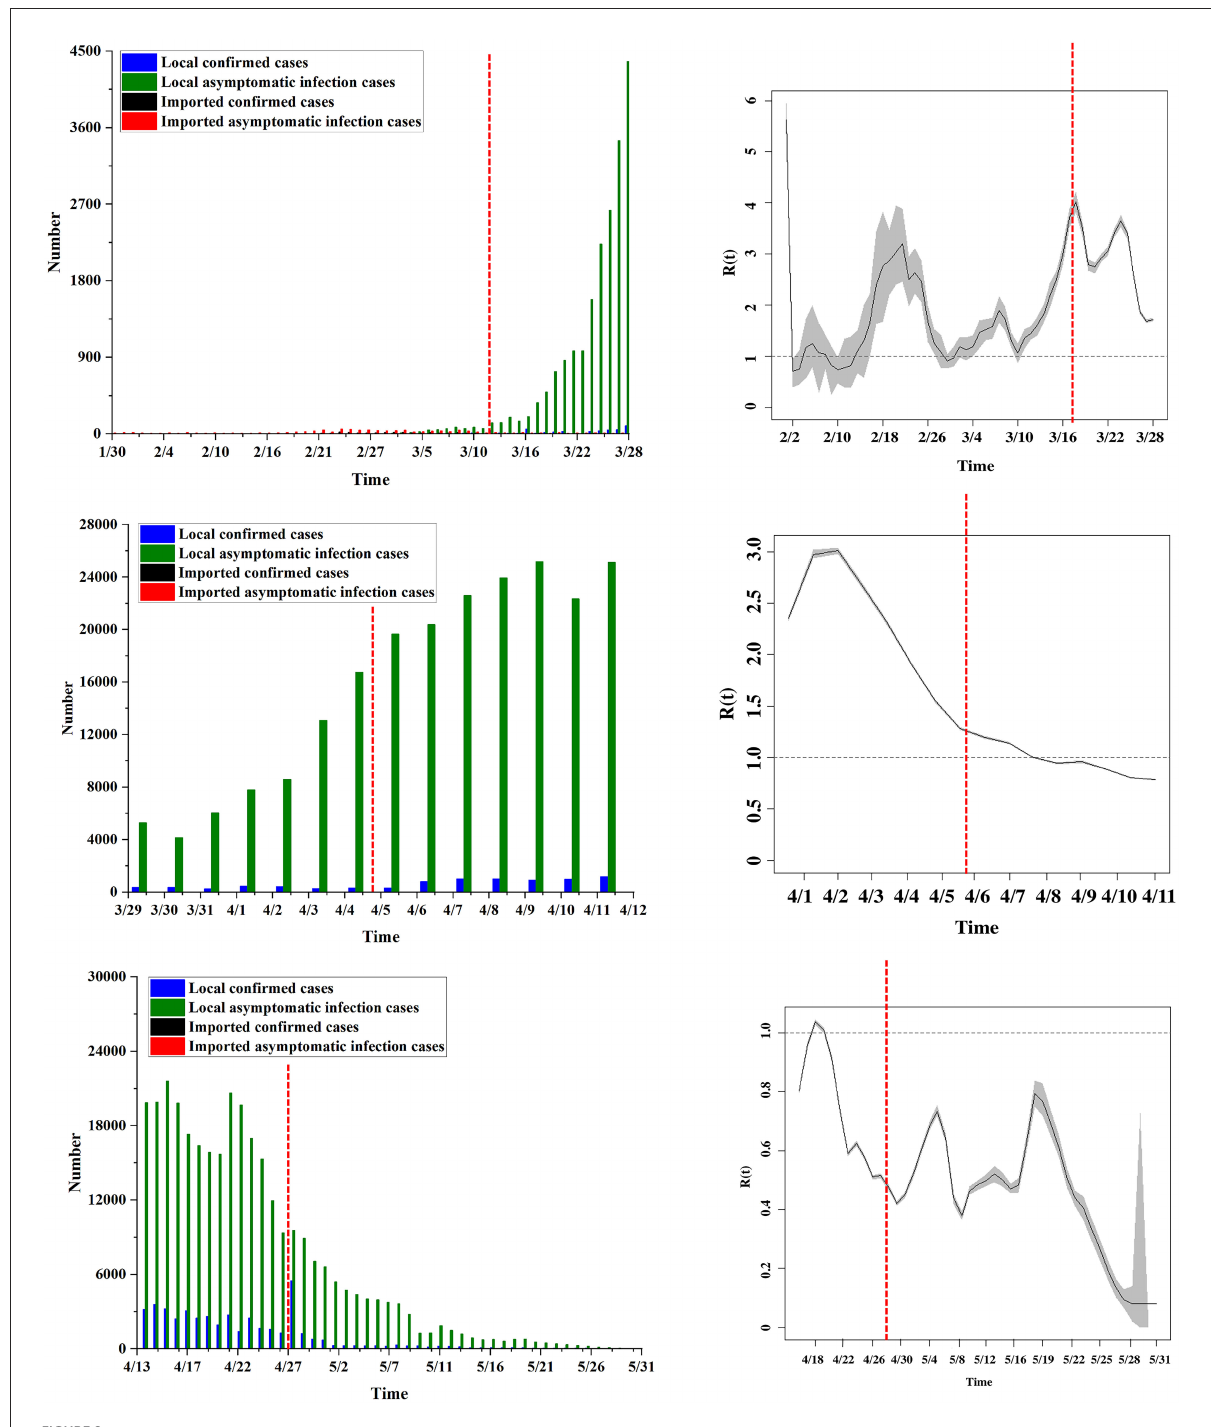
FIGURE2 The shifting pattern of R t . In the six stages, the daily new cases and the change trend of the R t value are